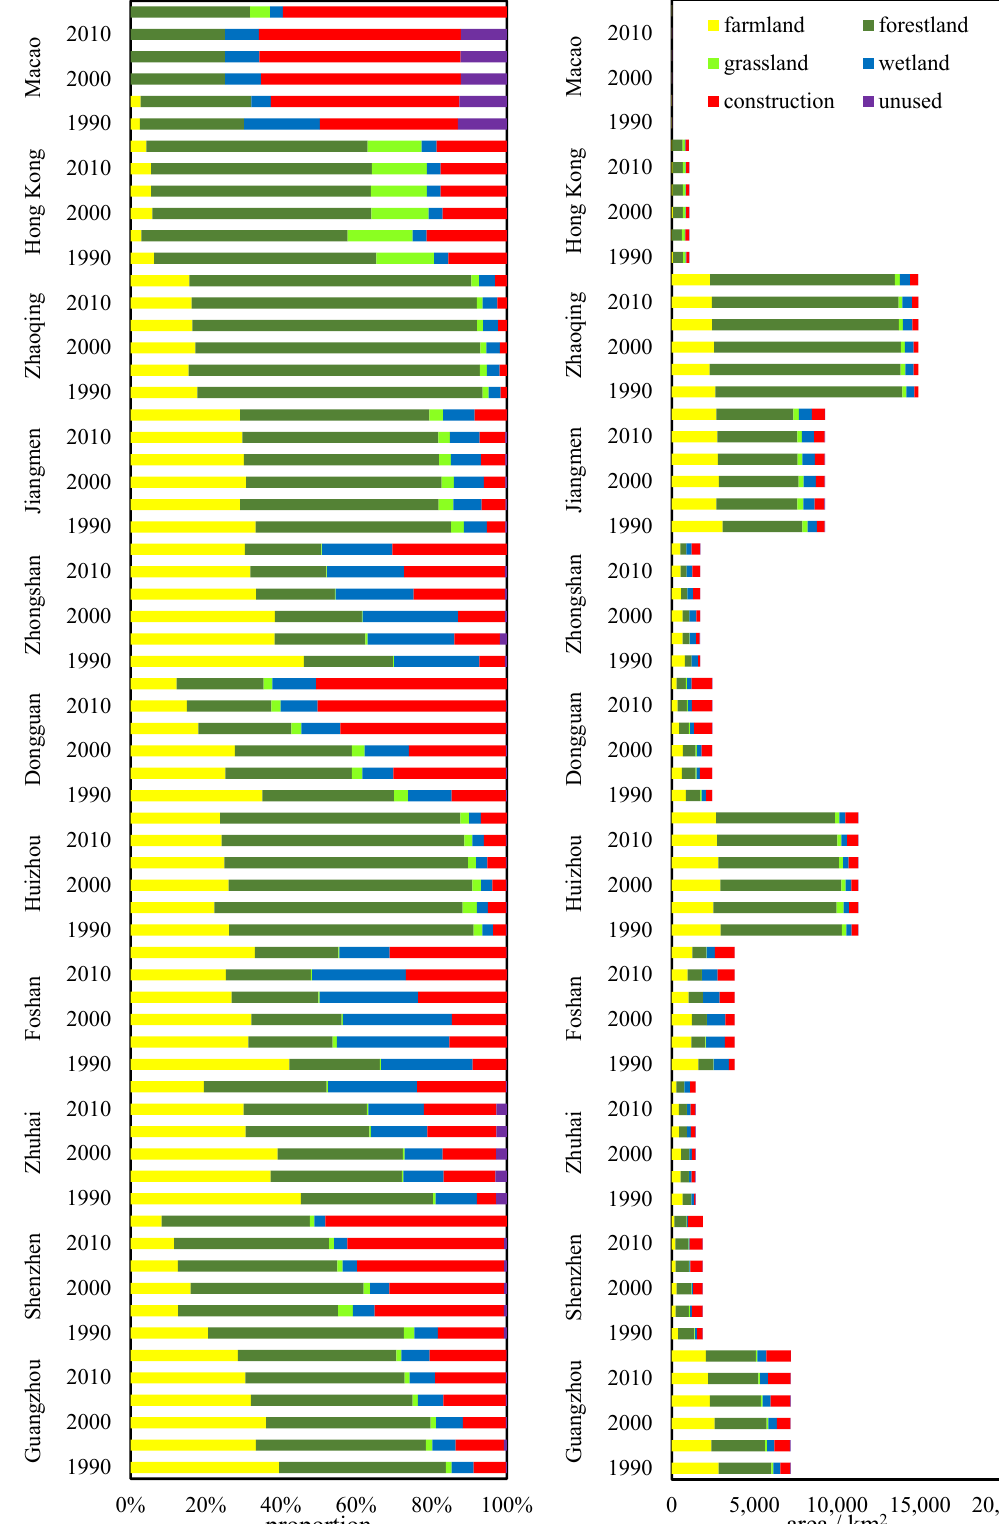
Figure 3. Proportion of land-use change and area of cities in the GBA in each period.